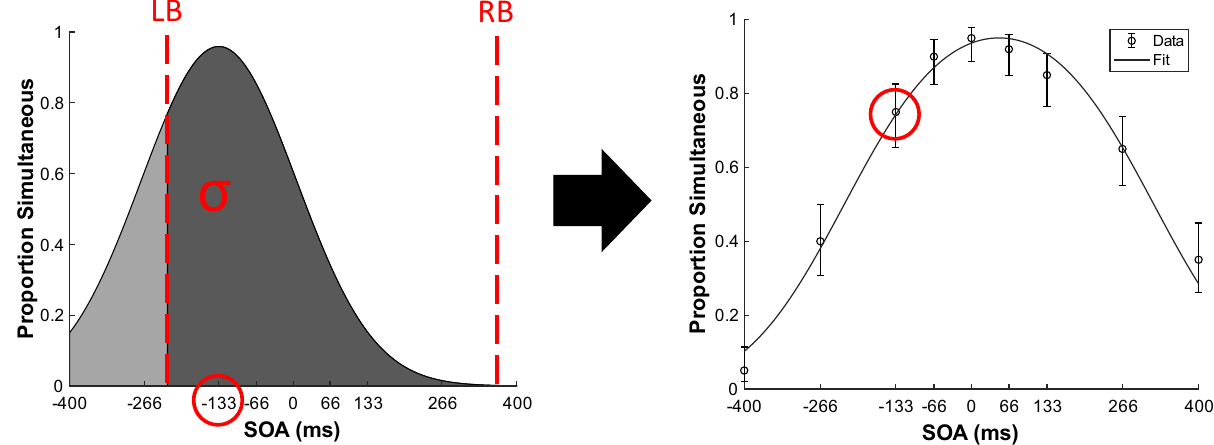
Figure 1. Visual depiction of the observer model and how the temporal integration window (TIW) is derived from it. The model assumes that when determining simultaneity, observers have a left boundary (LB) that determines whether the flash was simultaneous or late relative to the tone, and a right boundary (RB) that determines whether the tone was simultaneous or late relative to the flash. These are the first two parameters of the model (marked by red dashed lines in the left figure). Furthermore, on each trial the objective SOA (− 133 ms in this example) is assumed to be corrupted by Gaussian-distributed sensory noise, and therefore the perceived SOA will sometimes be greater or smaller than the objective SOA that was presented. The variance of this probability distribution of perceived SOAs (grey Gaussian distribution, σ) is the third and final parameter of the model. When the perceived SOA falls between the two boundaries, the model assumes that simultaneity is perceived. Hence, by calculating the area beneath the σ distribution where it lies between the two boundaries (the darker grey region in the left figure), we obtain the probability that the observer would perceive simultaneity at that SOA. These probabilities can be plotted as a psychometric function (the TIW). For example, the right figure shows the TIW obtained by fitting the model to a single observer’s data, with the example SOA circled in red and error bars denoting one standard error of the mean. By calculating the probability of perceiving simultaneity for each SOA and comparing these probabilities to the observed data, we thus compute the probability of obtaining the observed data given those parameter values. Then we use maximum likelihood estimation to find the values for the three parameters (LB, RB, and σ) that best fit the